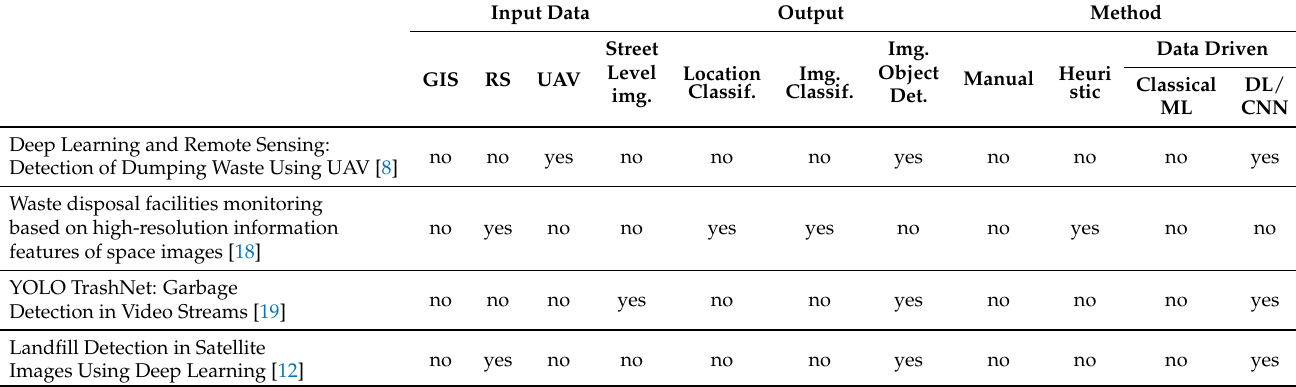
Table 1. Summary of relevant previous research on illegal landfill and waste dump detection. Works are presented in descending order of publication